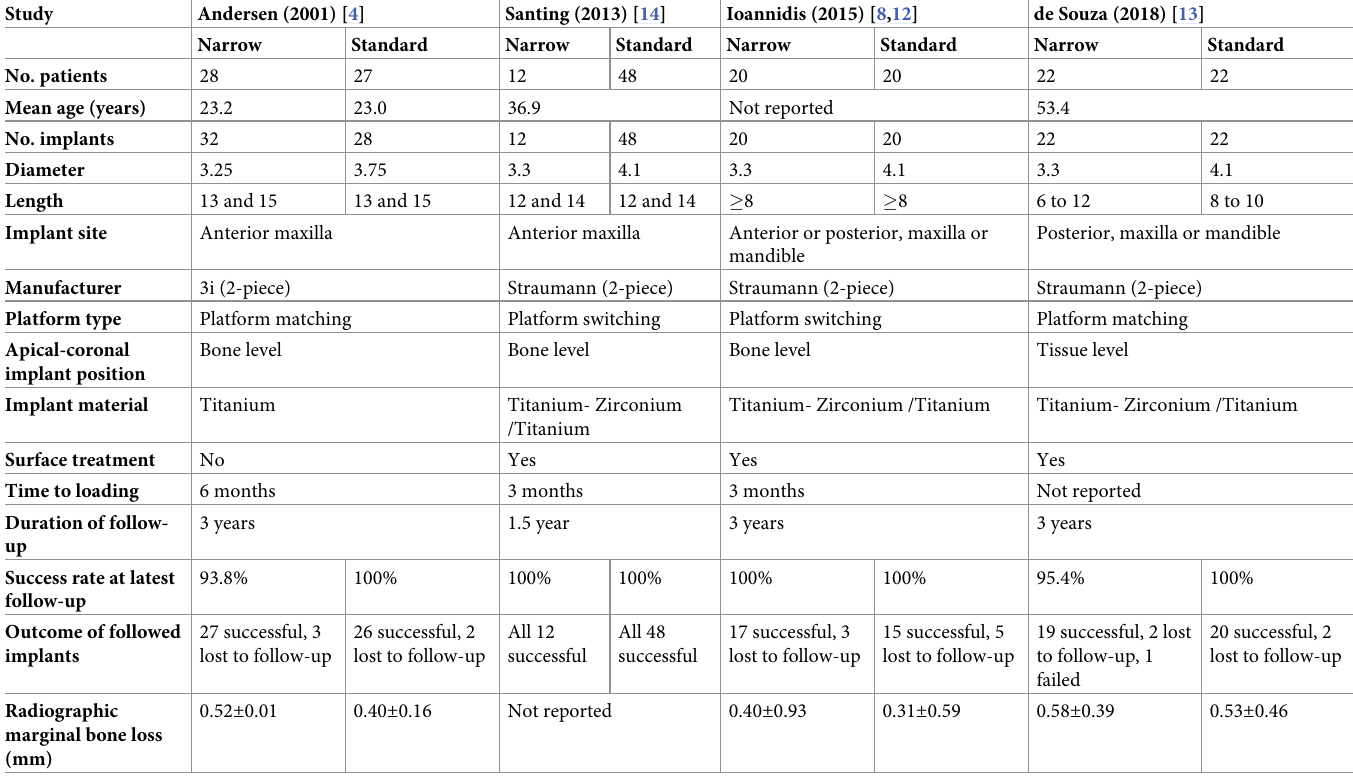
Table 1. Characteristics of the studies and detailed description of comparison